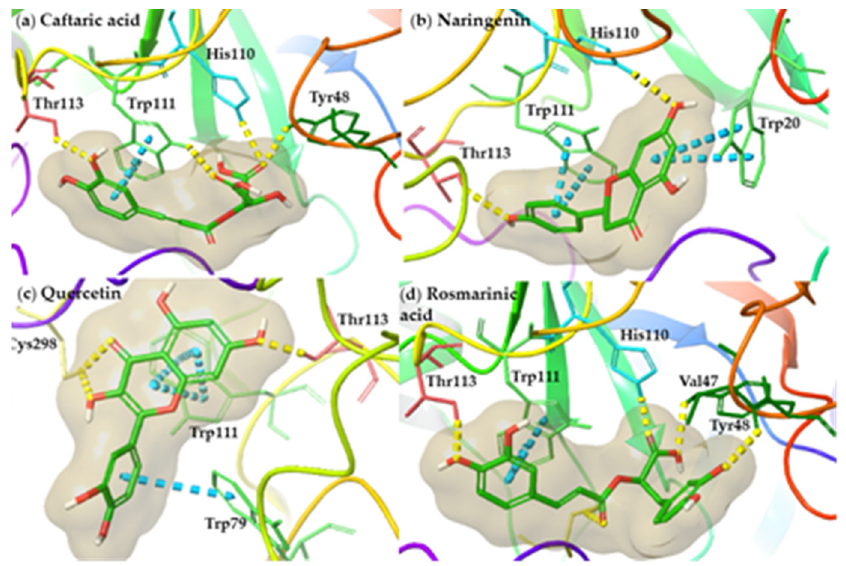
Figure 3. Representative binding poses and the crucial interactions of ( a ) caftaric acid, ( b ) naringenin, ( c ) quercetin, and ( d ) rosmarinic acid derived from molecular docking studies in the active site of AR. Hydrogen bonds are depicted with dashed yellow lines and pi–pi interactions with dashed blue lines.